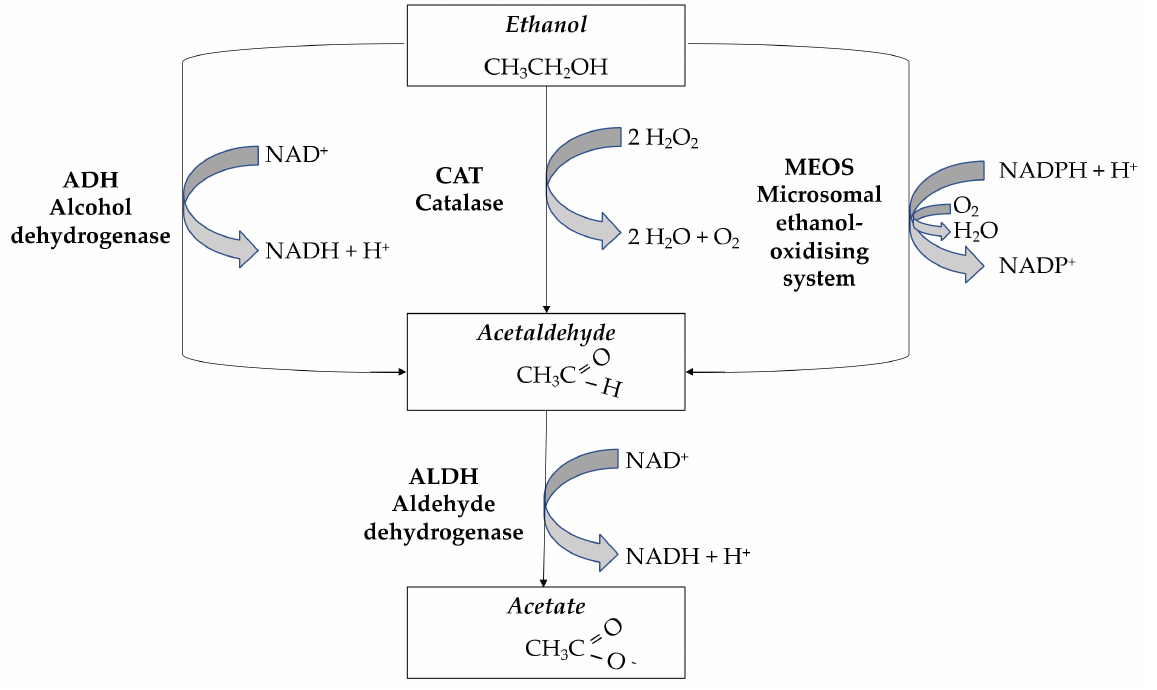
Figure 1. Ethanol metabolism. Acetaldehyde is not the only reactive metabolite of ethanol metabolism. Reactive oxygen species (ROS) may also be produced, in particular as by-products of oxidation via CYP enzymes. ROS are then transformed into less reactive products by antioxidative enzymes, while phase II conjugating enzymes, such as glutathione S-transferases (GSTs), participate in detoxification of their reactive secondary products [17]. Ethanol and acetalde- hyde levels depend on the activity of ADH and ALDH during detoxification, whereas GSTs regulate ROS levels via binding with glutathione. Thus, ROS production is related to alcohol metabolism to acetaldehyde and acetate and can potentially disturb cells’ oxidative balance and increase the risk of oxidative stress